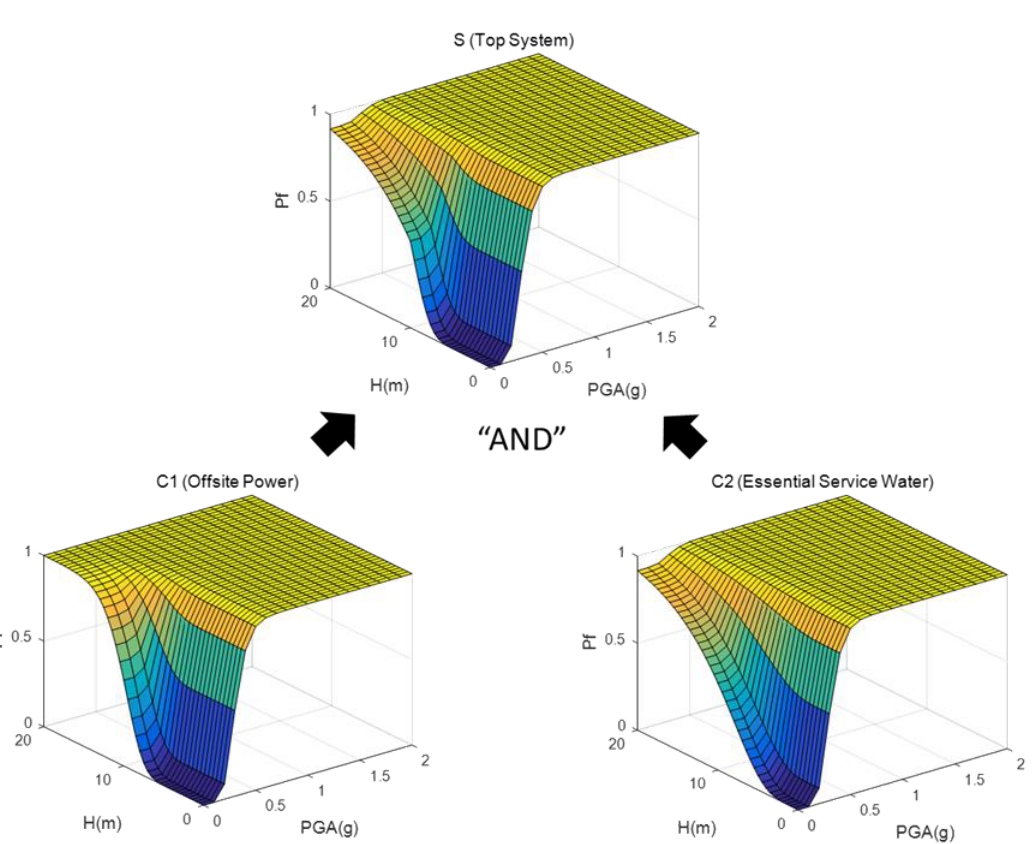
Figure 3. Multi-hazard system fragility results of the Boolean algebraic approach regarding the example C1 ∩ C2 (independent condition).